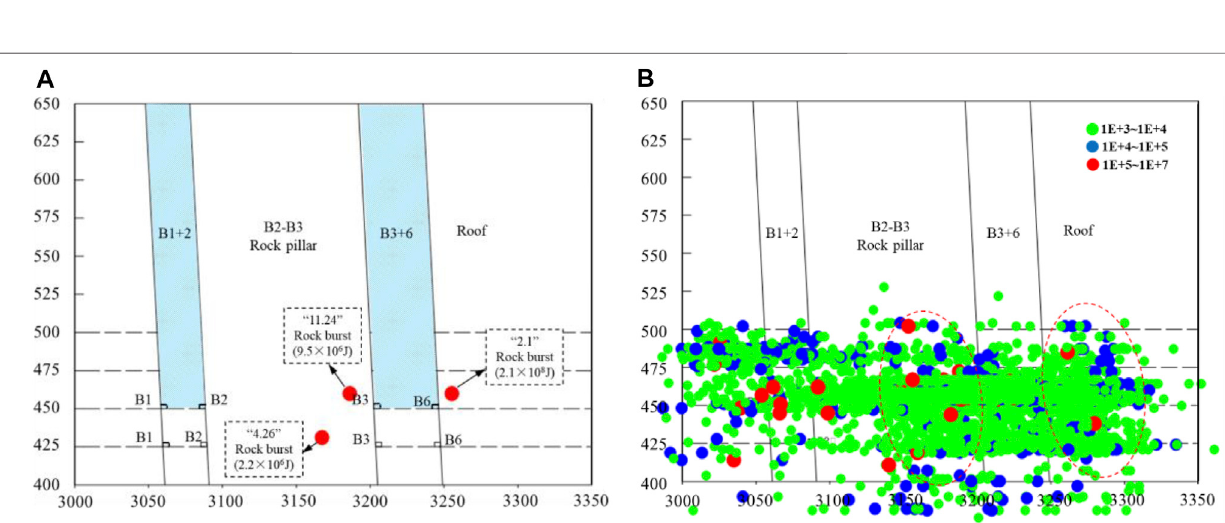
Frontiers in Earth Science |